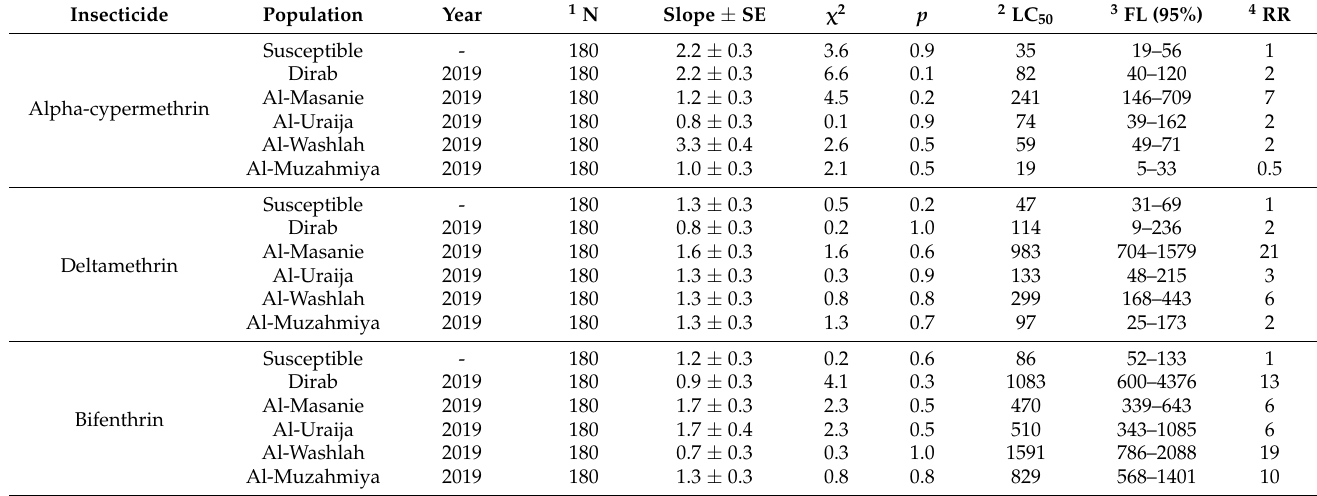
Table 2. Toxicity of pyrethroids in adult male house flies from different dairy